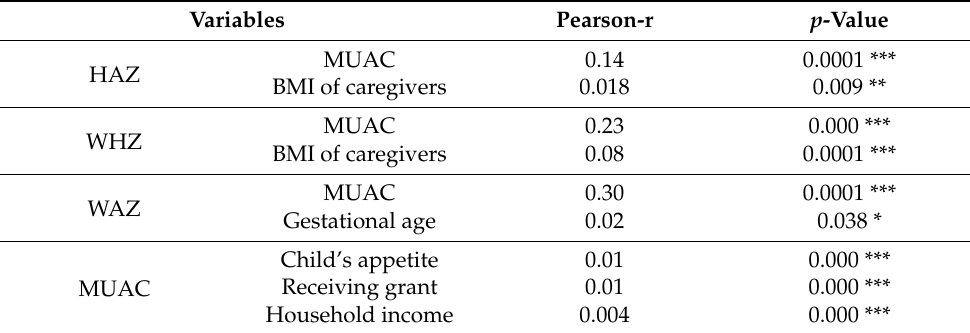
Figure 2. BMI classifications of caregivers. Table 6. Correlations between socio-demographic characteristics, dietary patterns, food insecurity, and